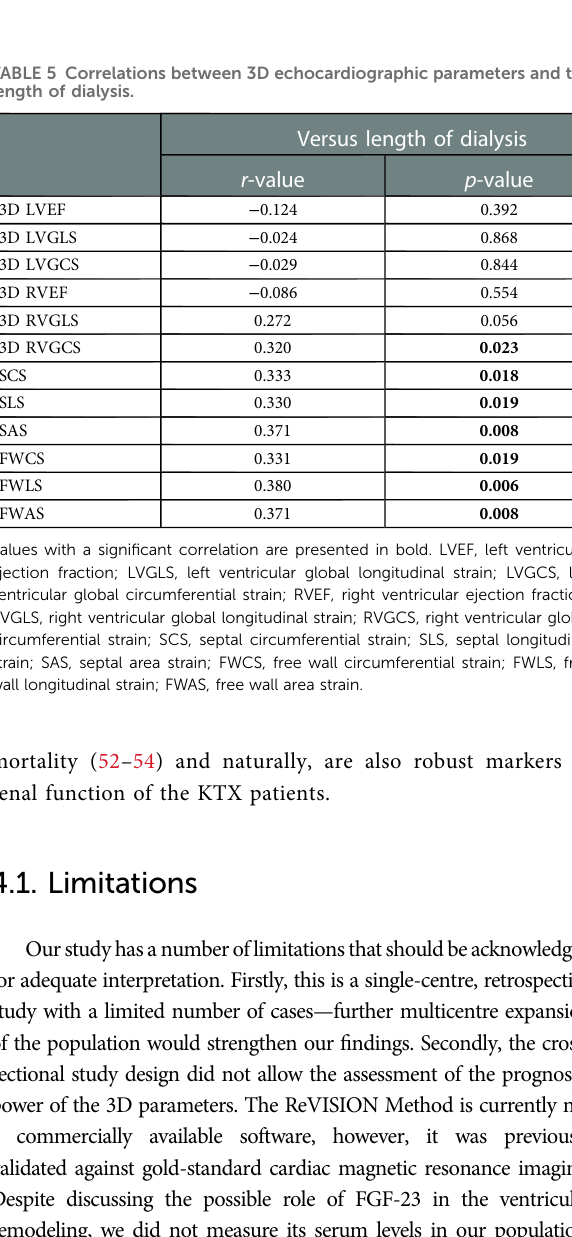
TABLE 5 Correlations between 3D echocardiographic parameters and the length of dialysis. Versus length of dialysis